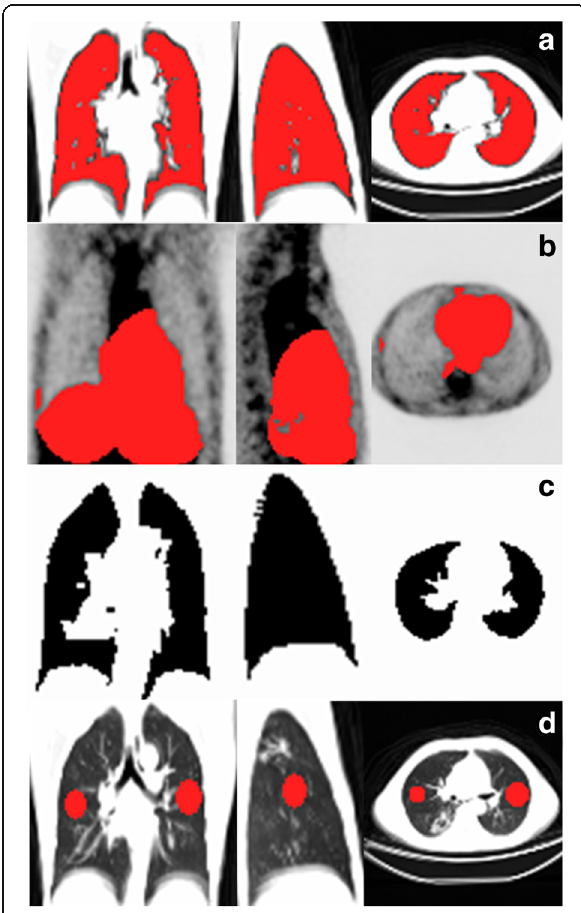
Fig. 2 Example of volumes of interest (in red) required for quantification. a Lung mask, on the combined CT images from baseline and follow-up scans. b Volume of structures surrounding the lung affecting motion misregistration (usually the mediastinum, liver and spleen) drawn on the overlaid PET images. We then deleted overlapping areas on the lung mask to leave only areas unaffected by misregistration. c Binary image representing the final lung mask. d Reference volumes of normal lung tissue, represented by two spheres in opposite lungs or ipsilateral lobes. It is also drawn on the overlaid CT images, but viewed alongside the PET images to ensure that it represents lesion-free